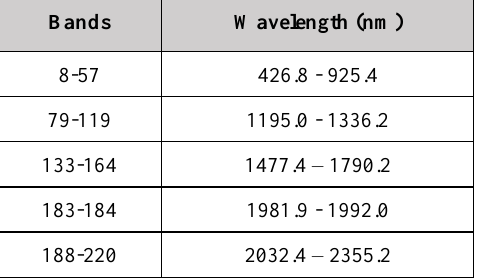
Table 1. Bands of Hyperion used in image processing